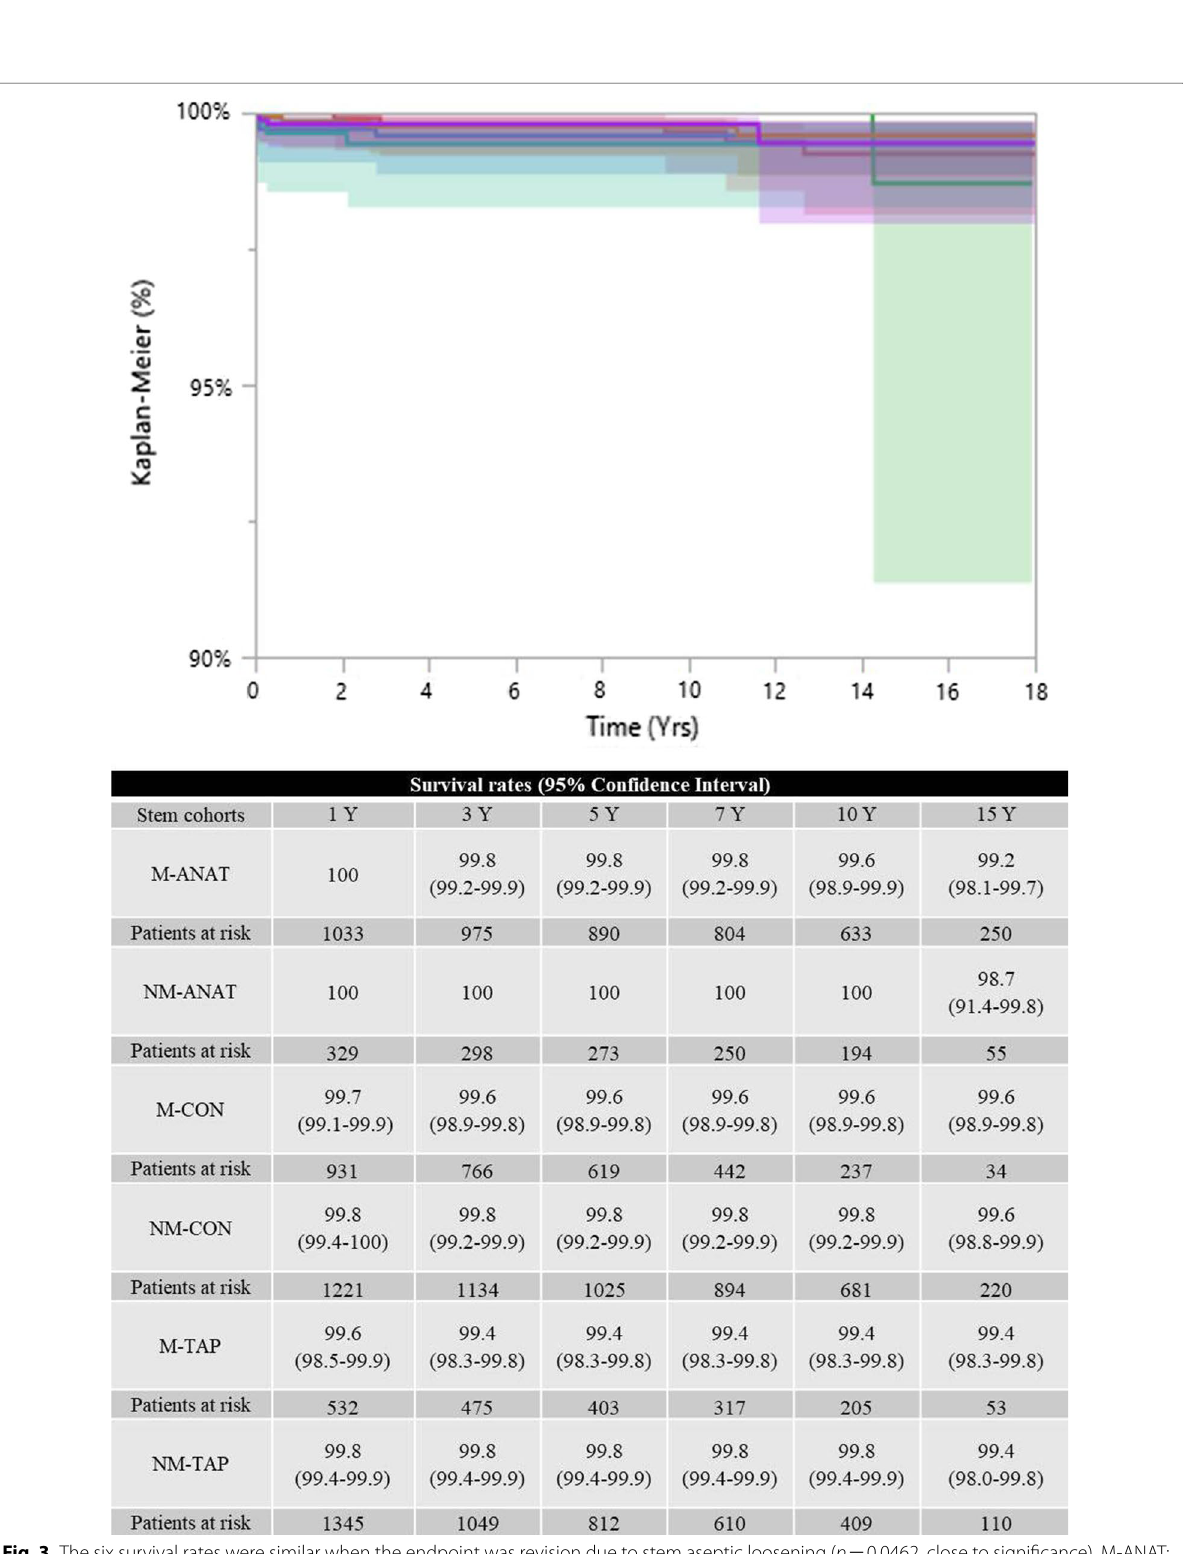
0.0462, close to significance). M-ANAT: =